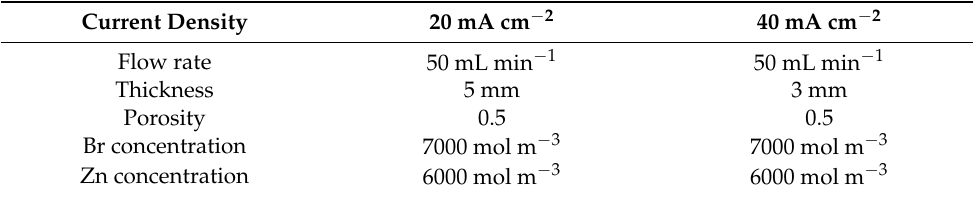
Table 9. Optimal combination of parameters at different current